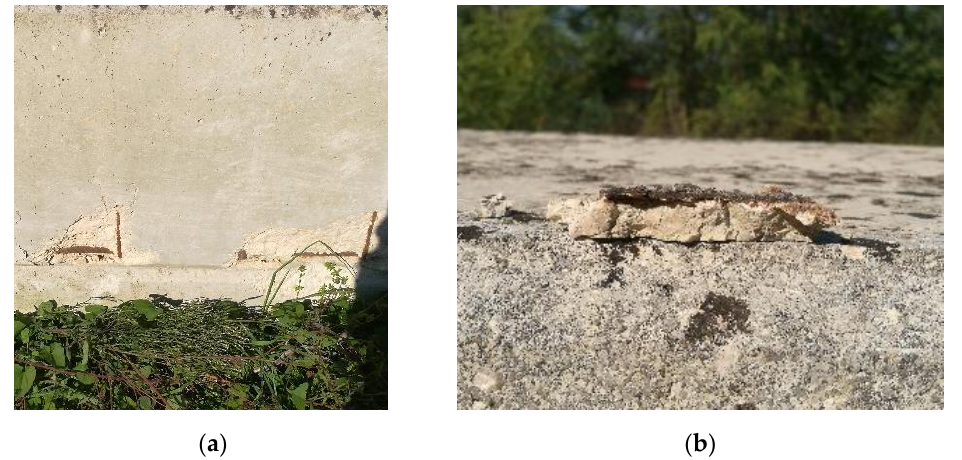
Figure 4. Spalling in column C after struck by hammer ( a ), detached cover due to hammer strike ( b ).